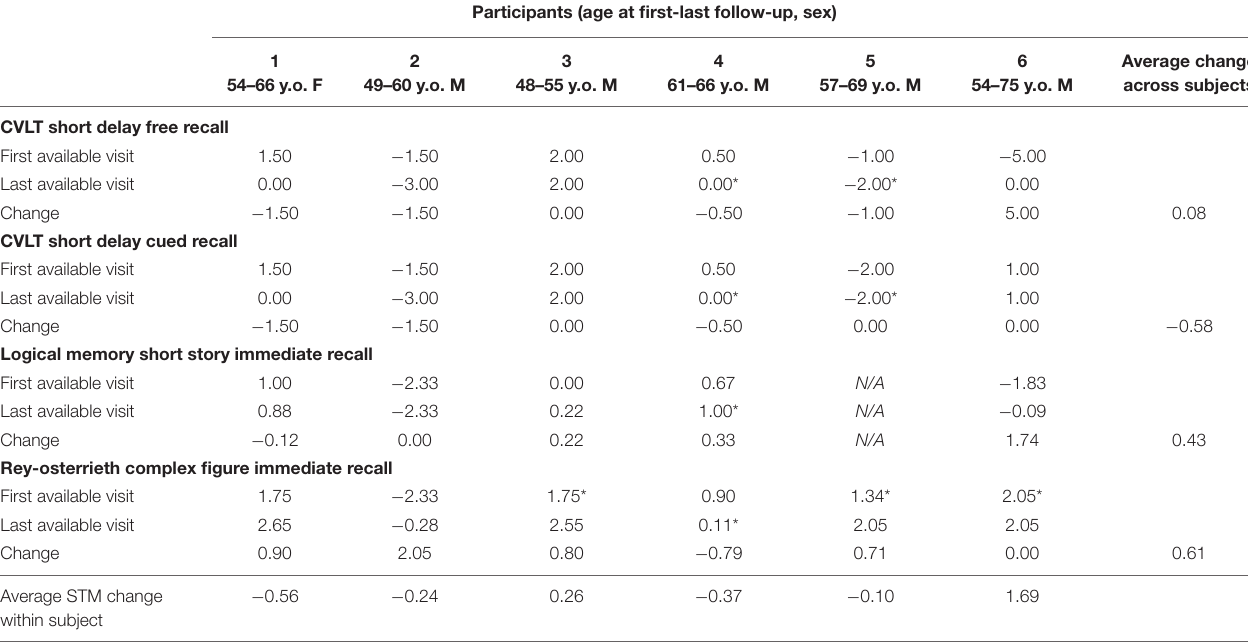
TABLE 3 | Short-term memory (STM) performance of the